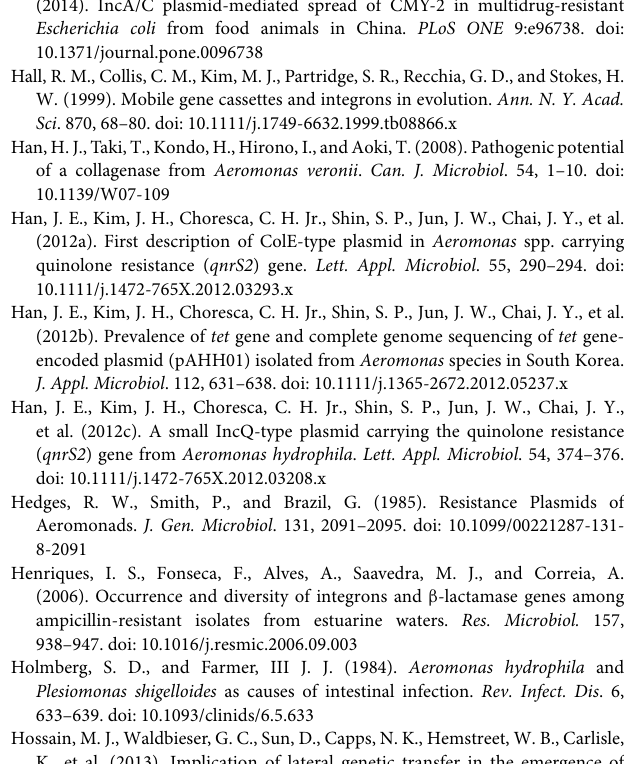
Figueras, M. J. (2005). Clinical relevance of Aeromonas sM503. Rev. Med. Microbiol . 16, 145–153. doi: